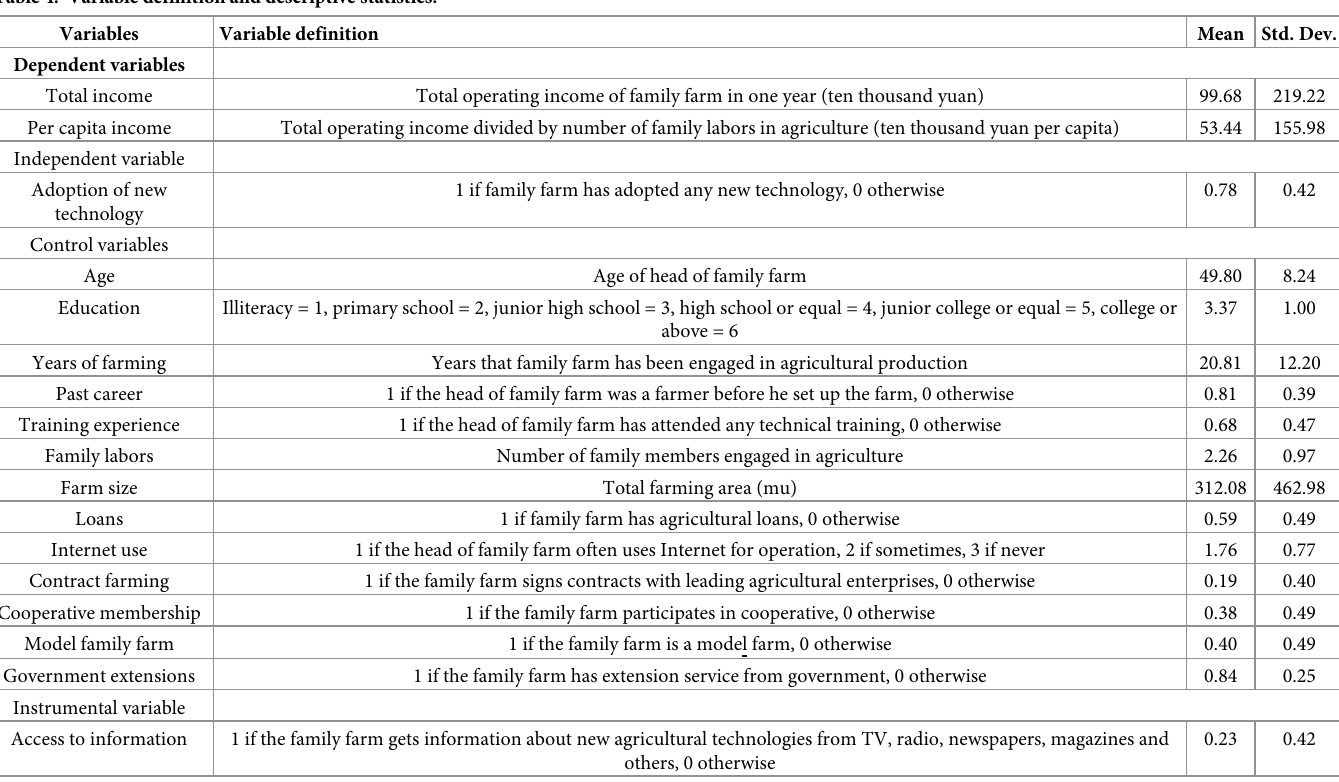
Table 4. Variable definition and descriptive